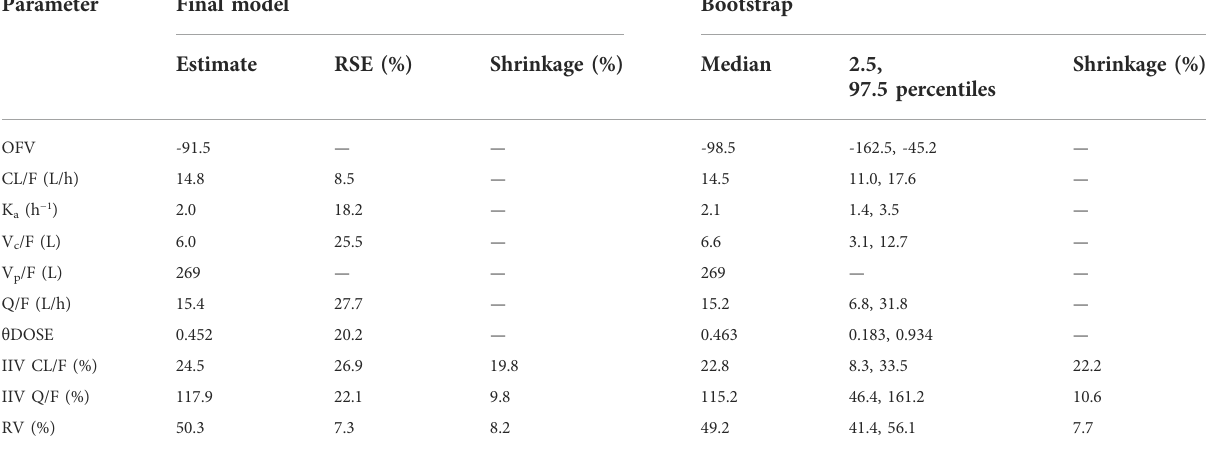
TABLE 3 PK parameter estimates and bootstrap results of fi nal model.